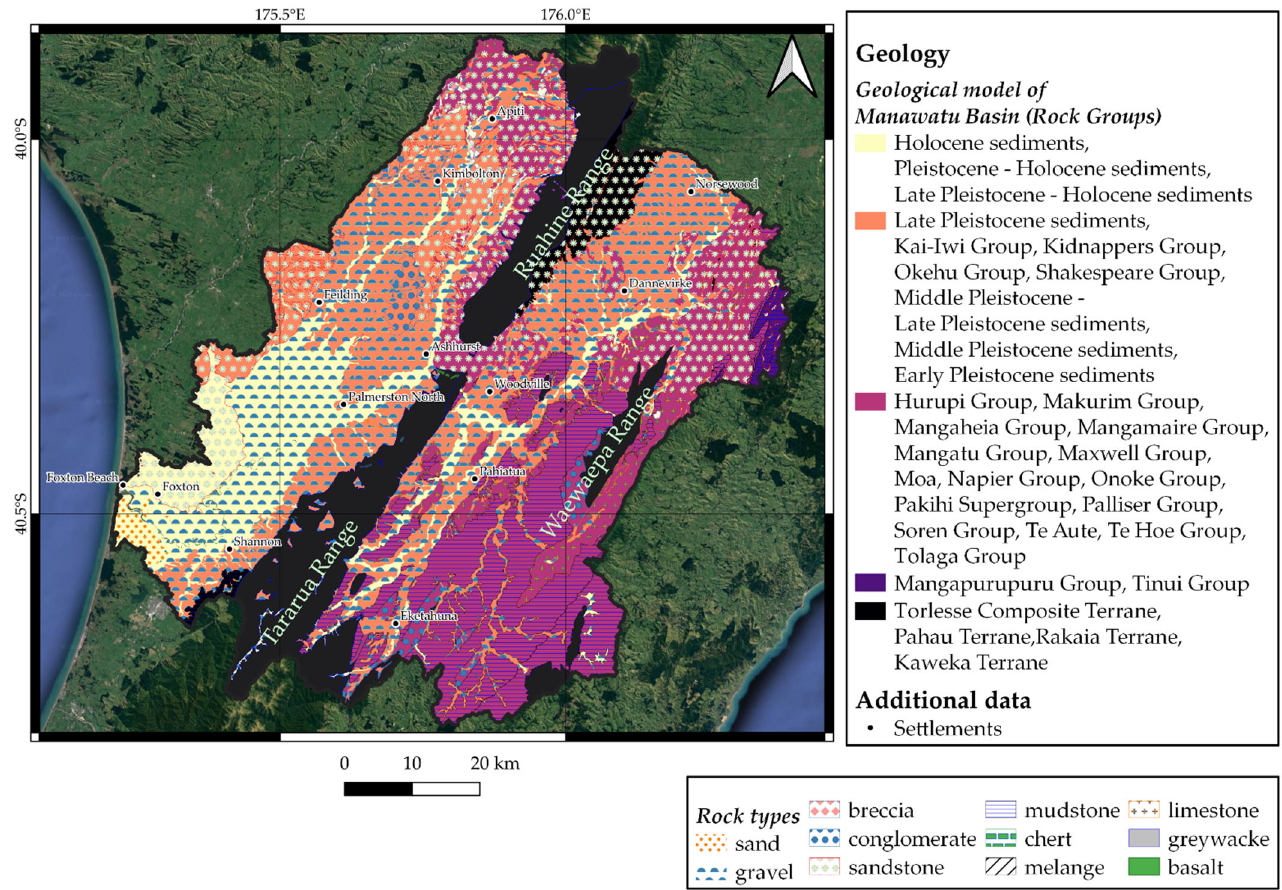
Figure 2. Geological model of Manawatu Basin based at the 1:250,000 scale, New Zealand geological map (Q-Map Series—https://www.gns.cri.nz/data-and-resources/geological-map-of-new-zealand/, accessed on 23 December 2022) [36]; background is Google terrain map.